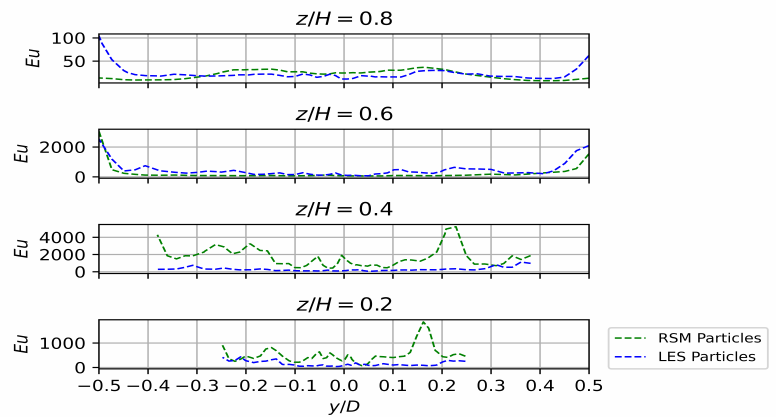
Figure 18. Euler number for the particle models as a function of the normalised y co-ordinate at various heights at flow-time 4 s.